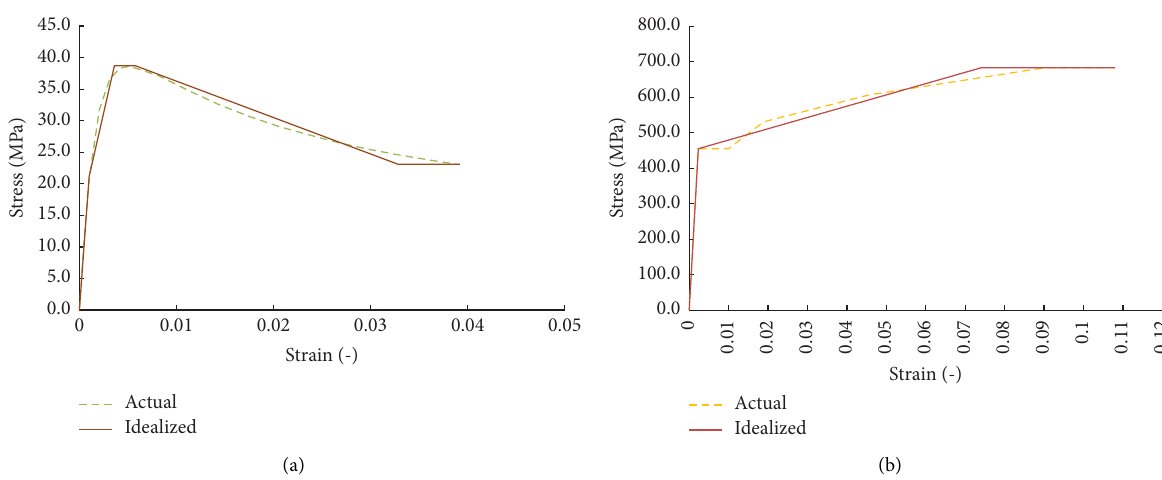
Figure 4: Concrete’s and longitudinal reinforcements’ curves: (a) backbone curve of confned concrete and (b) backbone curve of longitudinal reinforcements.